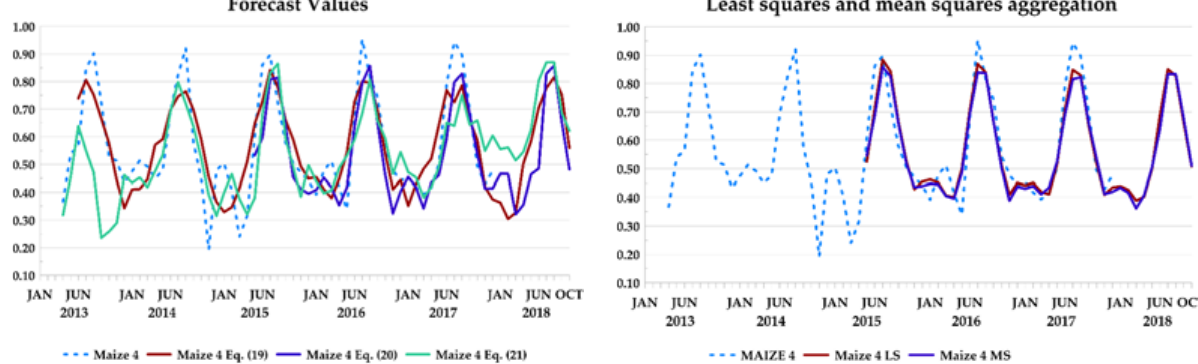
Figure 10. Forecast values for one-year time horizon given by the estimation models presented in Equations (19)–(21) and Figure 10. F orecast values for one ‐ year time horizon given by the estimation models pre ‐ least squares and mean squares aggregation sented in Equations (19) to (21) and least squares and mean squares aggregation models.